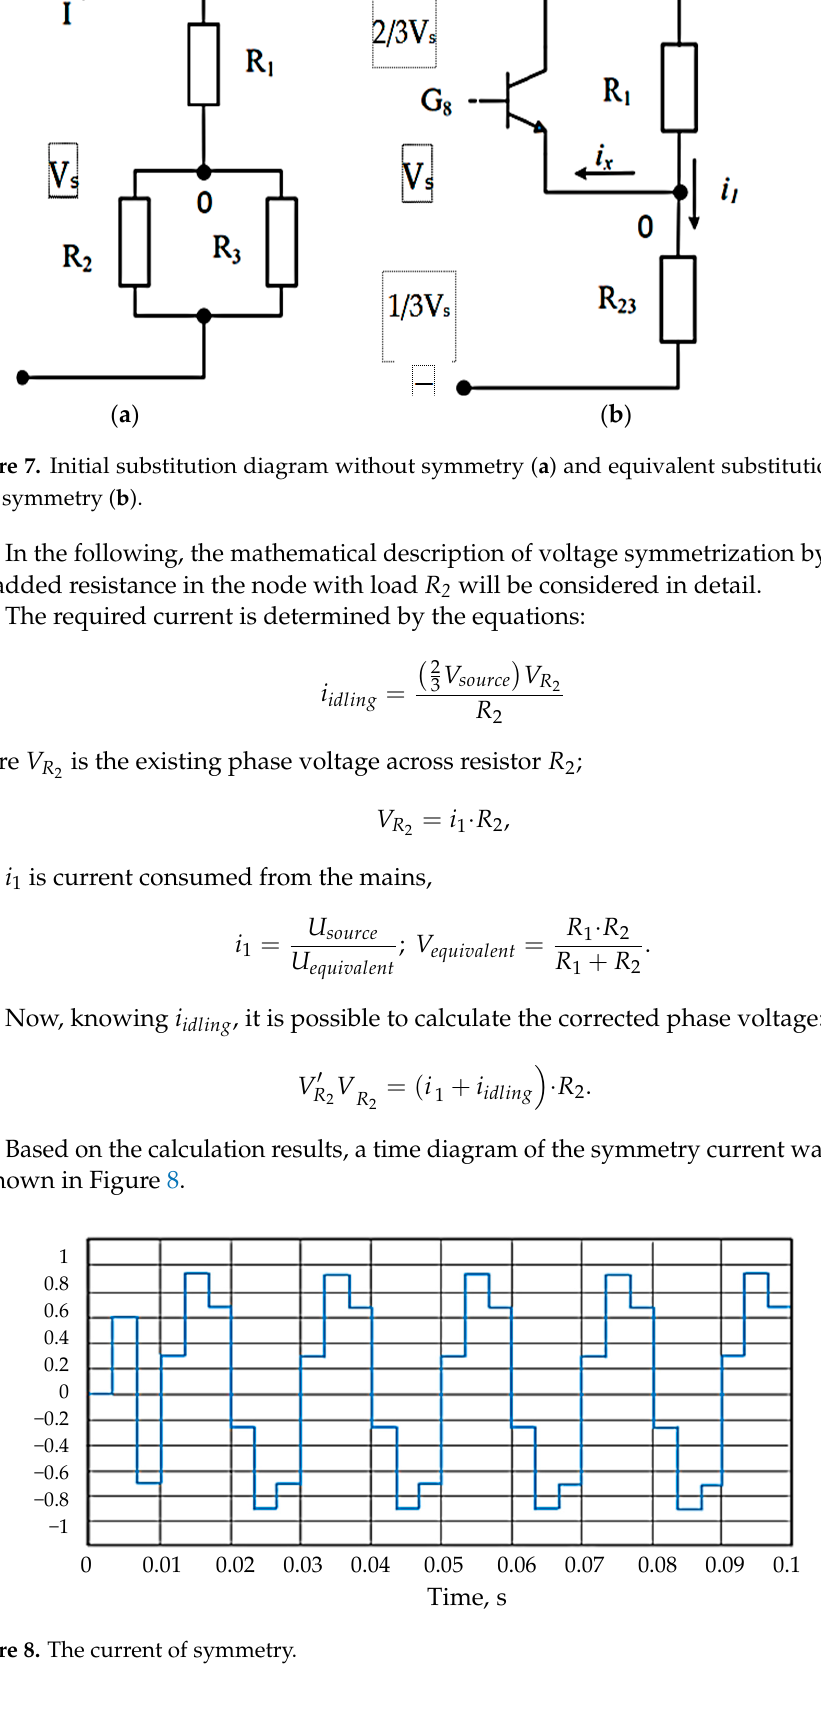
Figure 9. The model of the symmetry device based on the PI controller in MATLAB/Simulink [41]. In order to verify the effectiveness of the proposed voltage symmetry system for current unbalance, a system control algorithm was constructed (Figure 9), according to